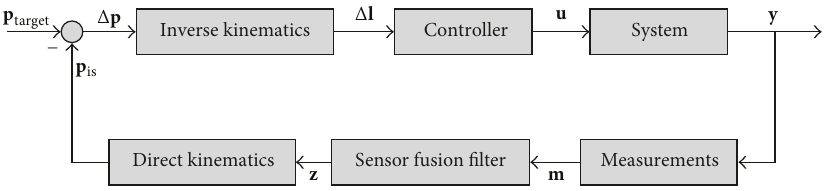
Figure 4: Pose control concept for parallel mechanisms using the algorithms from Sections